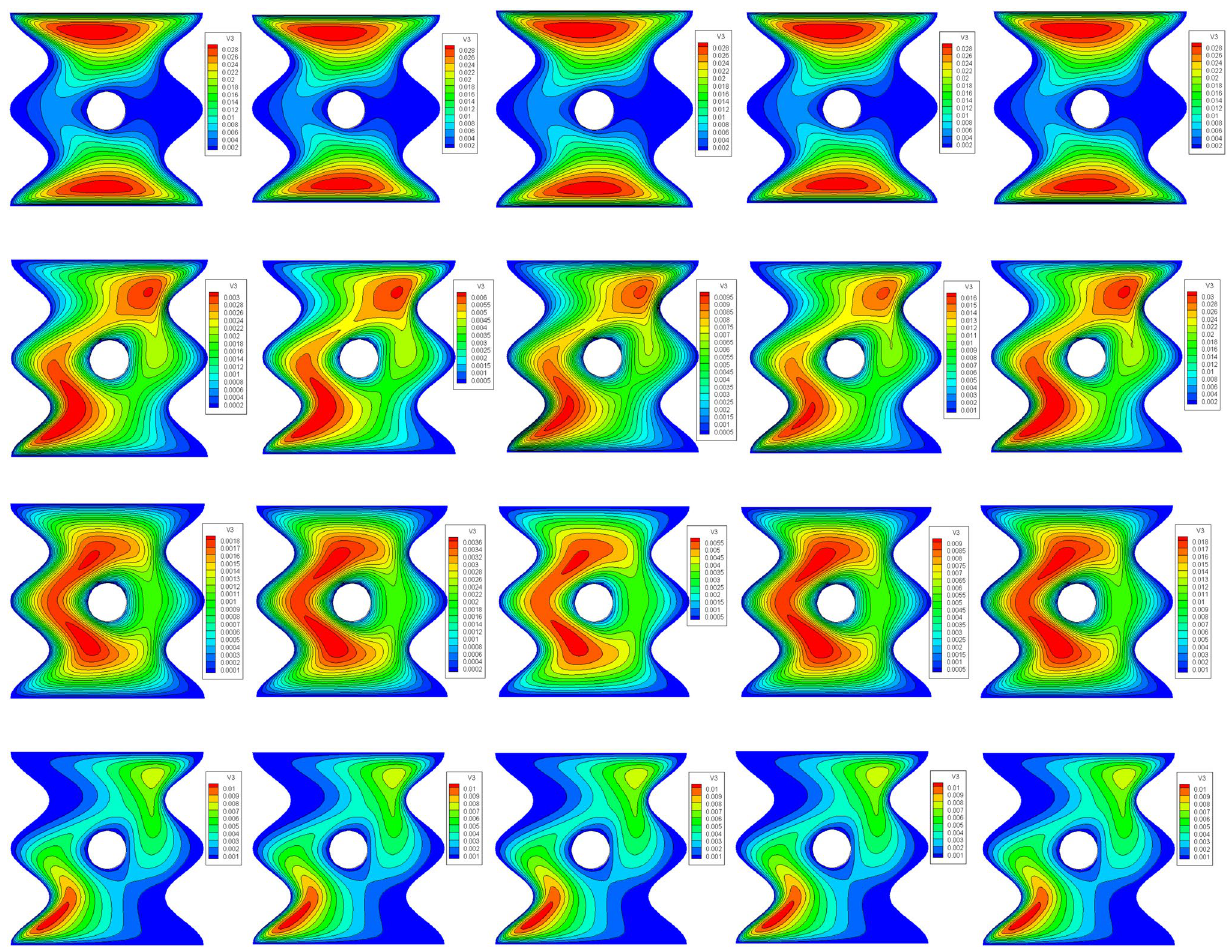
centrations (4th row), for TiO –Cu/water hybrid nanofluid at the 2 moderate values; Ha = 10 , Da = 10 – 3 , Ri = 1 , Gr = 1 , H * = 10 , R = 0 . 5 , c d ε = 0 . 5 , γ = 0 . 5 , Φ = π/ 3 , ϕ = ϕ = ϕ / 2 , ϕ = 0 . Cu TiO 2